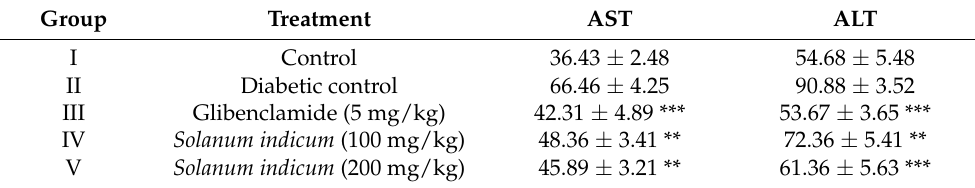
Table 6. Effect of SIE on ALT and AST levels in STZ-induced diabetic rats. Group